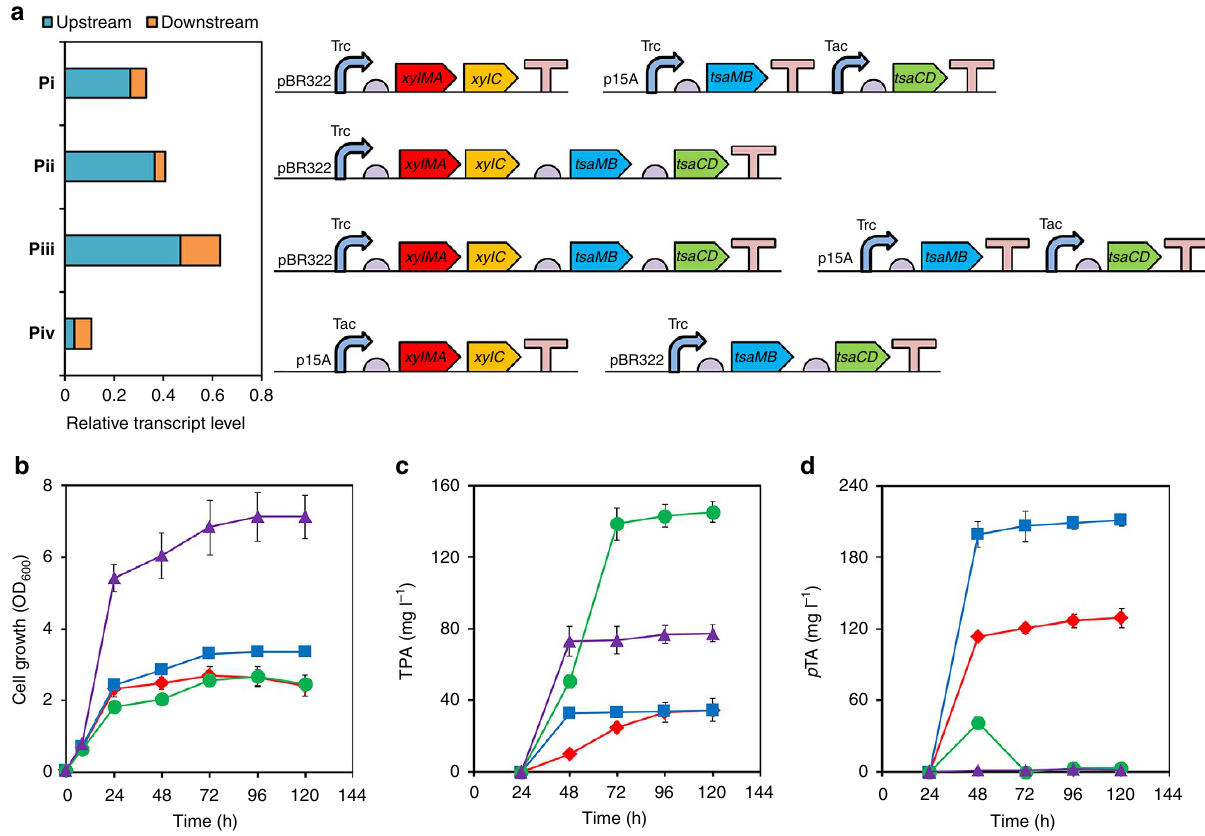
Figure 2 | Pathway assembly with modular optimization and transformation of p X into TPA in shake-flask cultures. ( a ) Schematic illustration of the constructed plasmids for pathway genes expression (right panel) and the sums of transcript levels of upstream and downstream pathway genes in the four pathway configurations, Pi , Pii , Piii and Piv (left panel). Trc and Tac, IPTG-inducible promoters; pBR322 and p15A, replication origins; half-circle box, ribosome-binding site (RBS); T-shape box, terminator. ( b ) Cell growth, ( c ) TPA production and ( d ) byproduct p TA formation profiles of E. coli DH5 a harbouring Pi (red diamond), Pii (blue rectangle), Piii (green circle) and Piv (purple triangle) by flask cultures. Values and error bars represent the mean and s.d. of duplicate experiments.